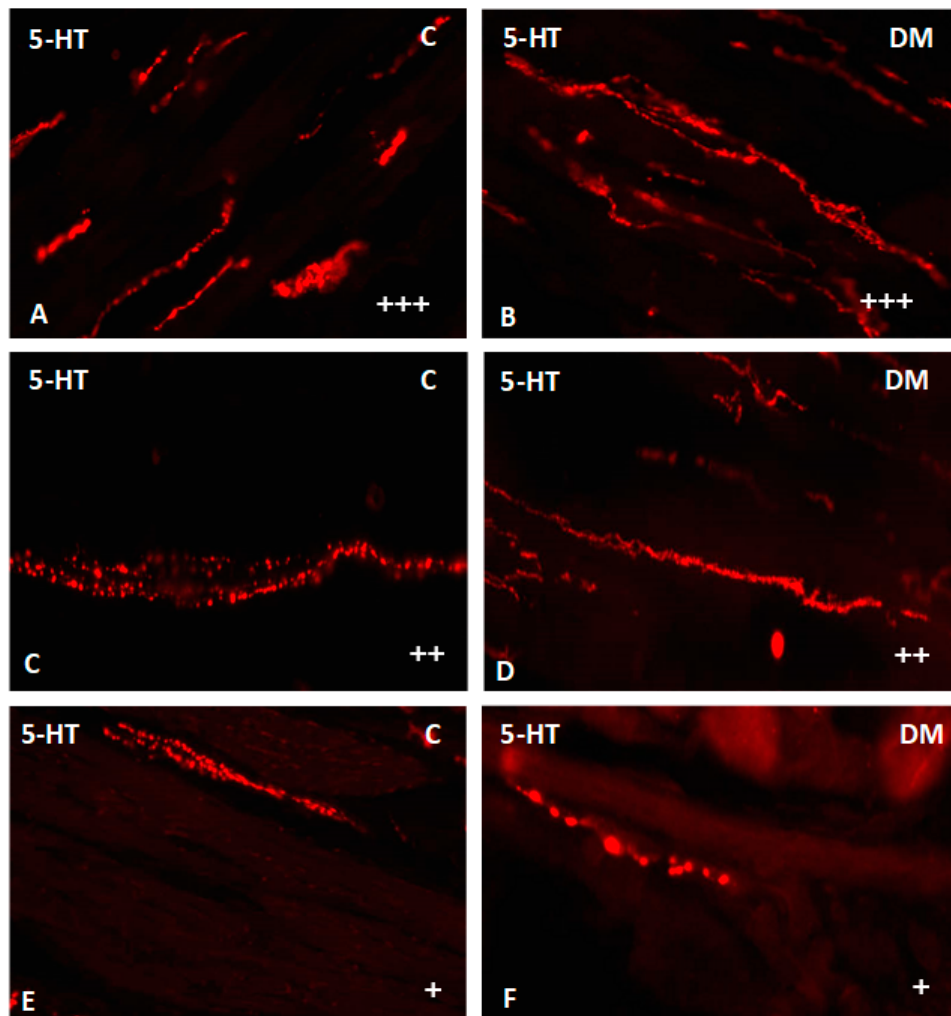
Figure 10. Serotonin-immunoreactive nerve fibers in various parts of submucosal layer in the porcine small intestine. ( A ) The duodenum in control animals (+++); ( B ) the duodenum in experimental group (+++); ( C ) the jejunum in control animals (++); ( D ) the jejunum in experimental group (++); ( E ) the ileum in control animals (+); ( F ) the ileum in experimental group (+). (+)—single nerve fibers; (++)—rare nerve fibers; (+++)—very dense nerve fibers.